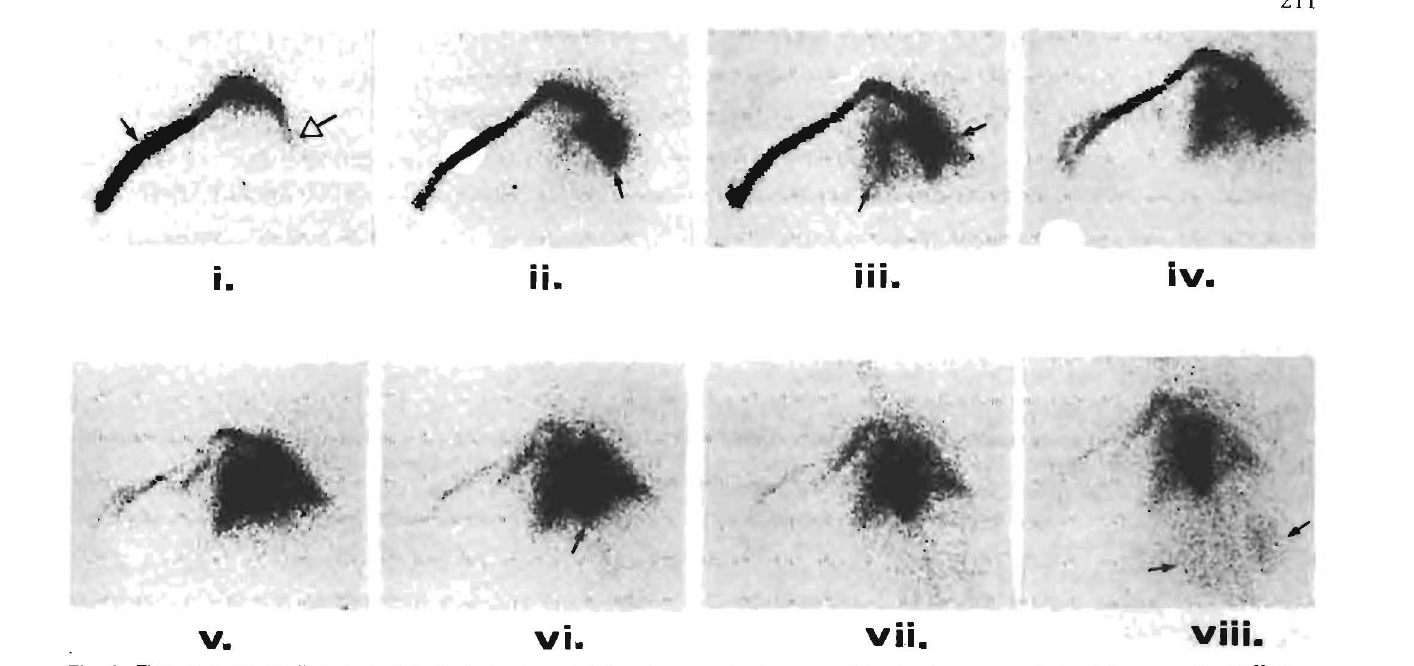
Fig. 4. First passage cardiac study (left Ventral anterior Oblique) sequential frames at 1/s after intravenous bolus injection of 6mCi 99mTc - DTPA. Note how the isotope is transported via the vena cava superior (i) (-» into the diHerent cardiac chambers i.e. right atrium (i) (-», right ventricle (ii) (->), through the lungs (iif.-vi) (-» and into the left cardiac (vf.-viii) chambers with final distribution via the aorta to the remainder of the body. Note the early appearance (7-8s post injection) in the kidneys (vii-viii) (-» of the